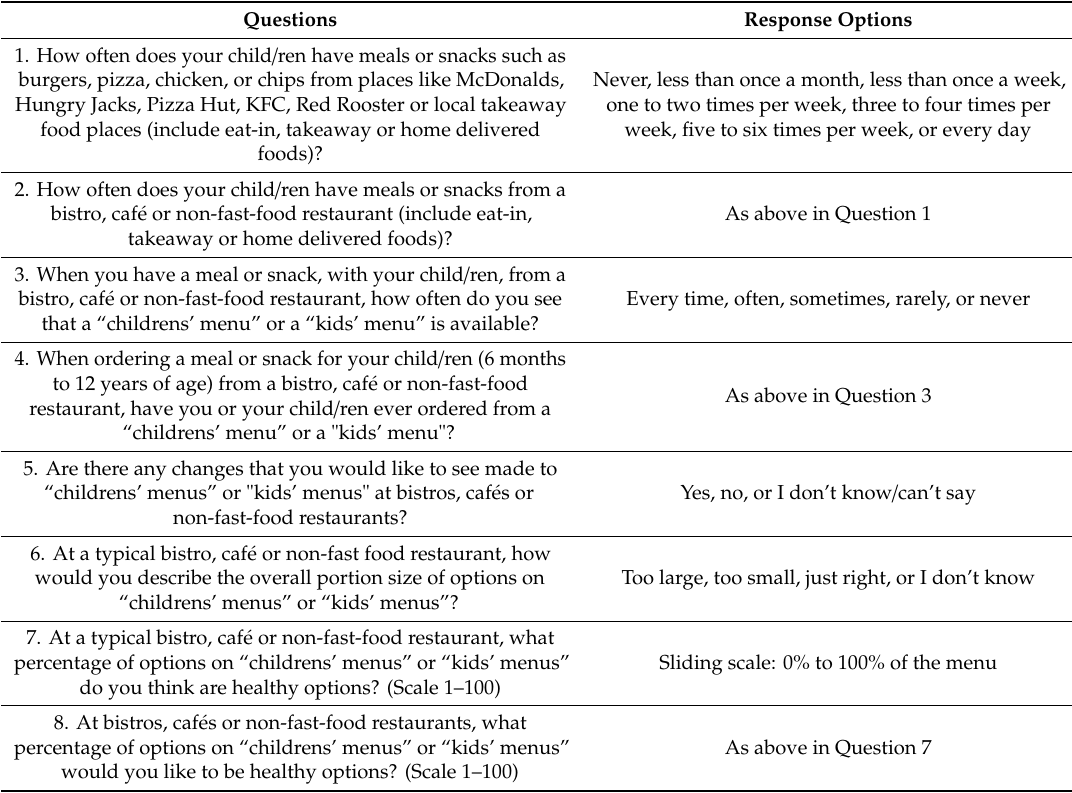
Table 1. Survey questions and response